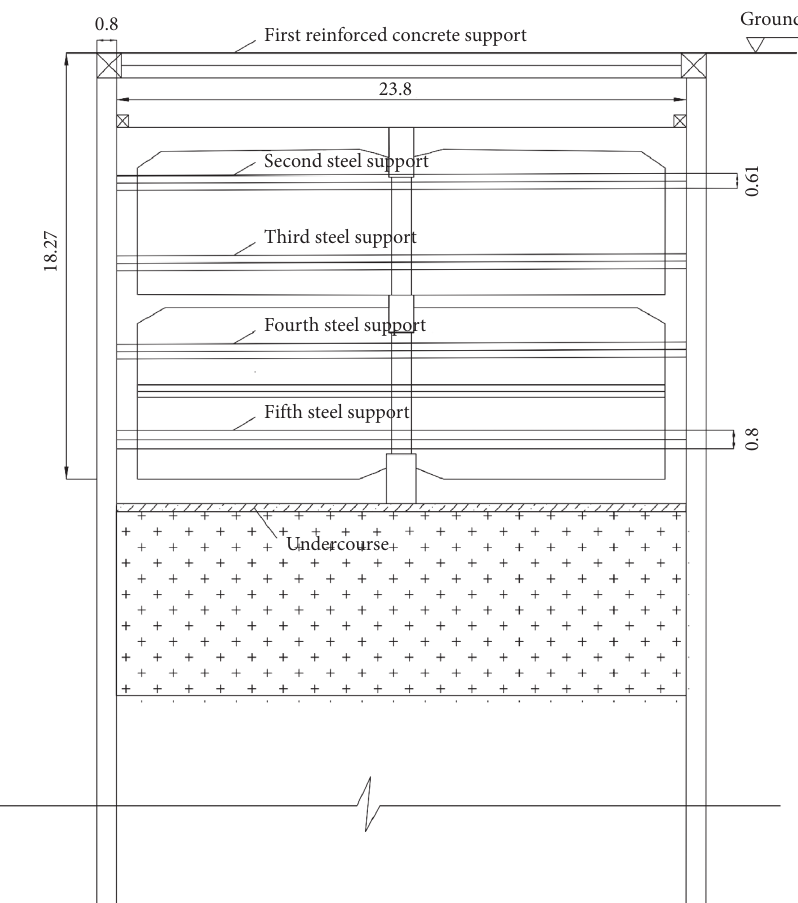
Figure 4: Cross section of the foundation